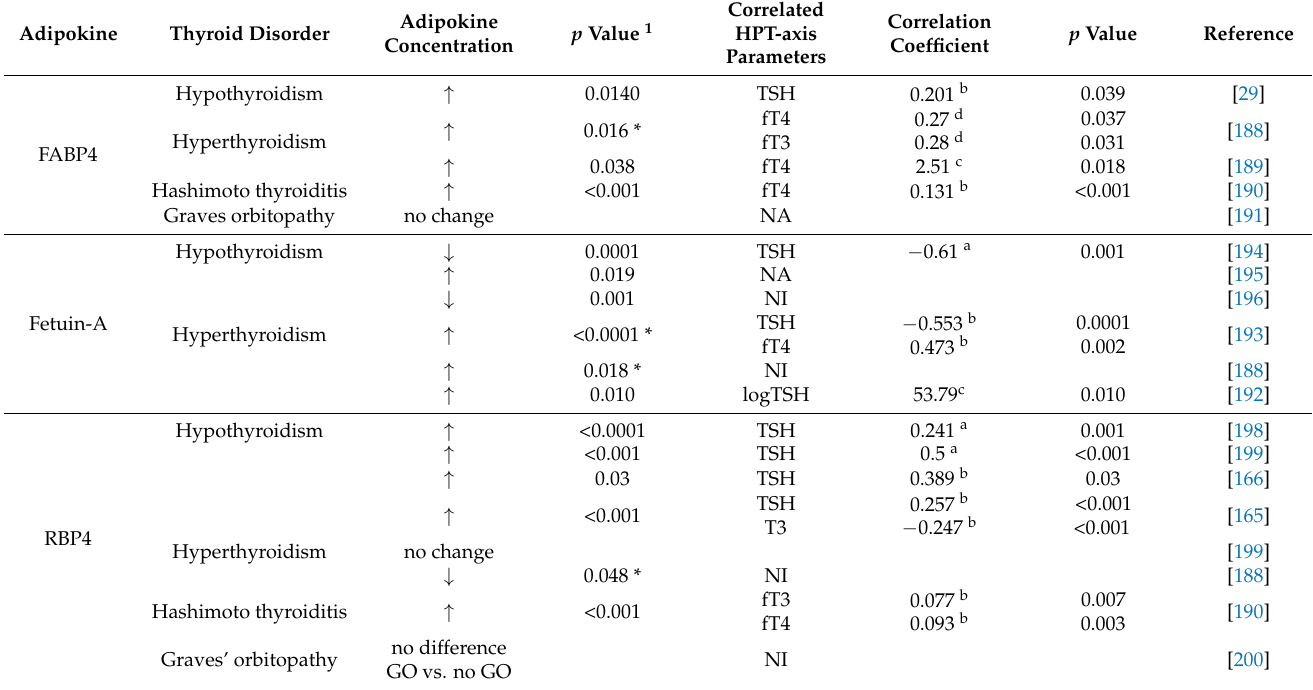
Table 1. Summary of studies assessing FABP4, fetuin-A and RBP4 concentrations in thyroid